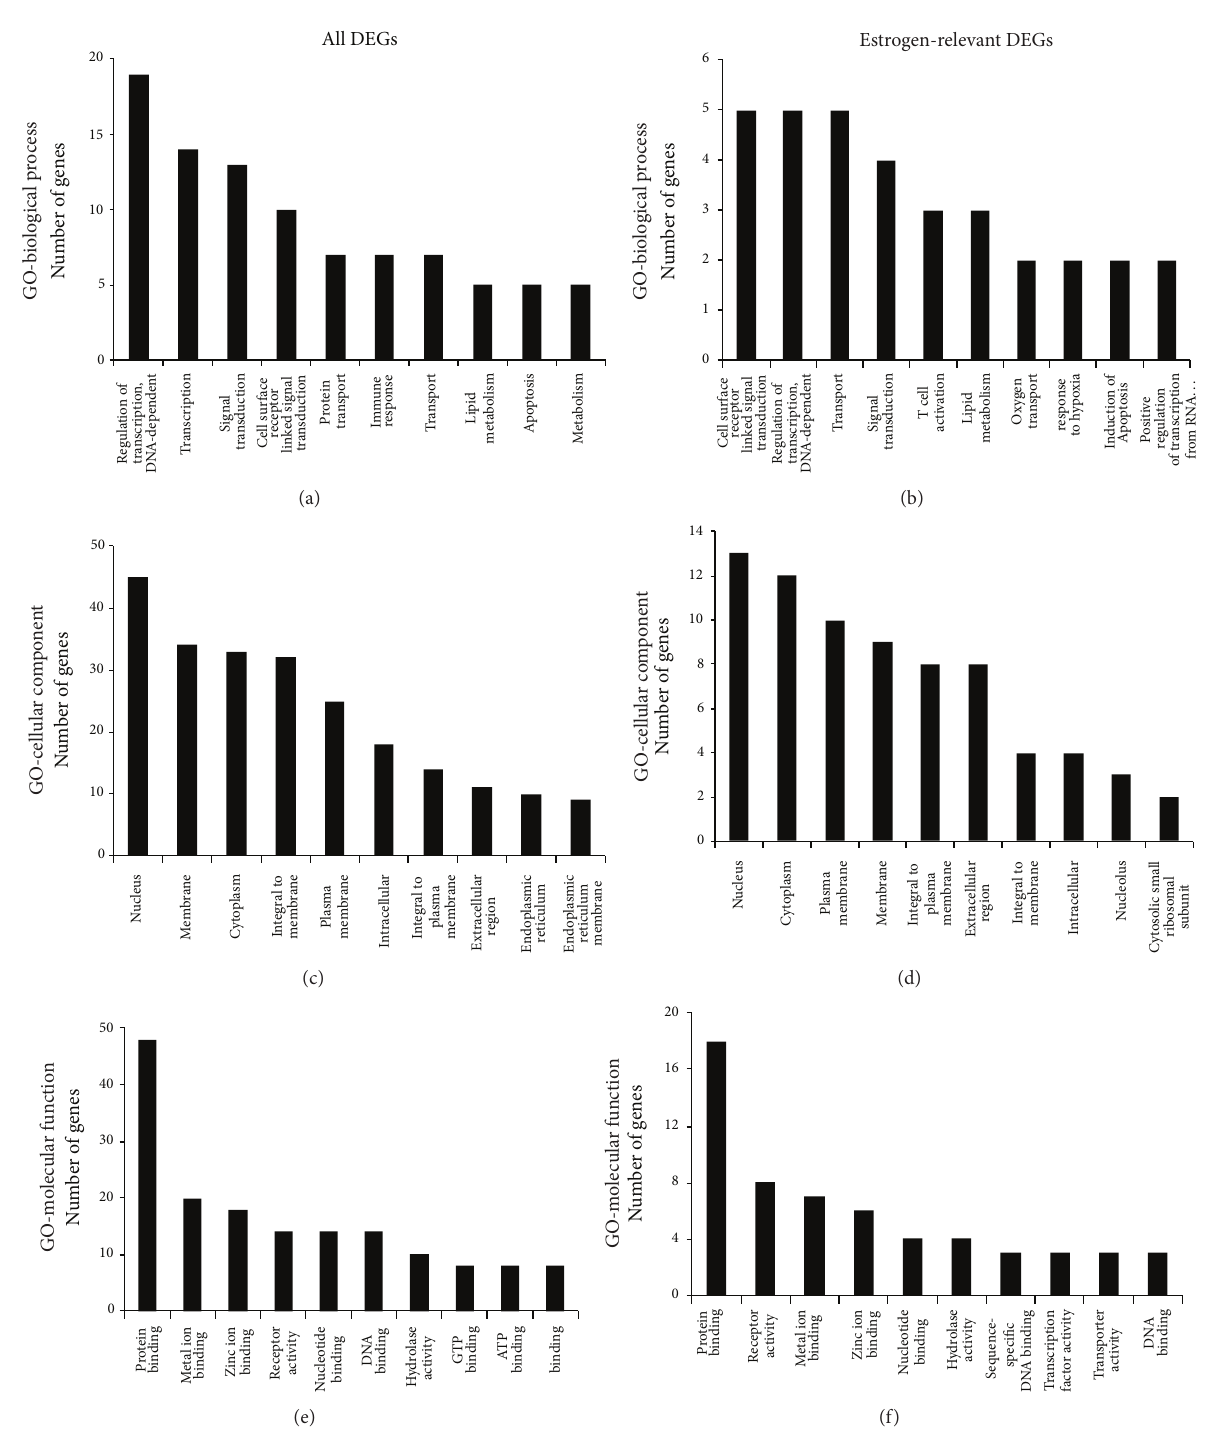
Figure 3: Lists of top ten GO terms for DEGs in healthy females and males. GO term covers three domains: biological process, cellular component, and molecular function. The left panels showed the GO terms for 358 DEGs in healthy females and males. The right panels showed the GO terms for 116 estrogen-relevant DEGs in healthy females and males. DEGs in healthy females’ and males’ comparison mainly perform DNA-dependent regulation of transcription (TR), biochemical reaction in nucleus, and protein binding and so forth. Estrogen- relevant DEGs widely participated in the cell surface receptor linked signal transduction, biochemical reaction in nucleus, protein binding and so